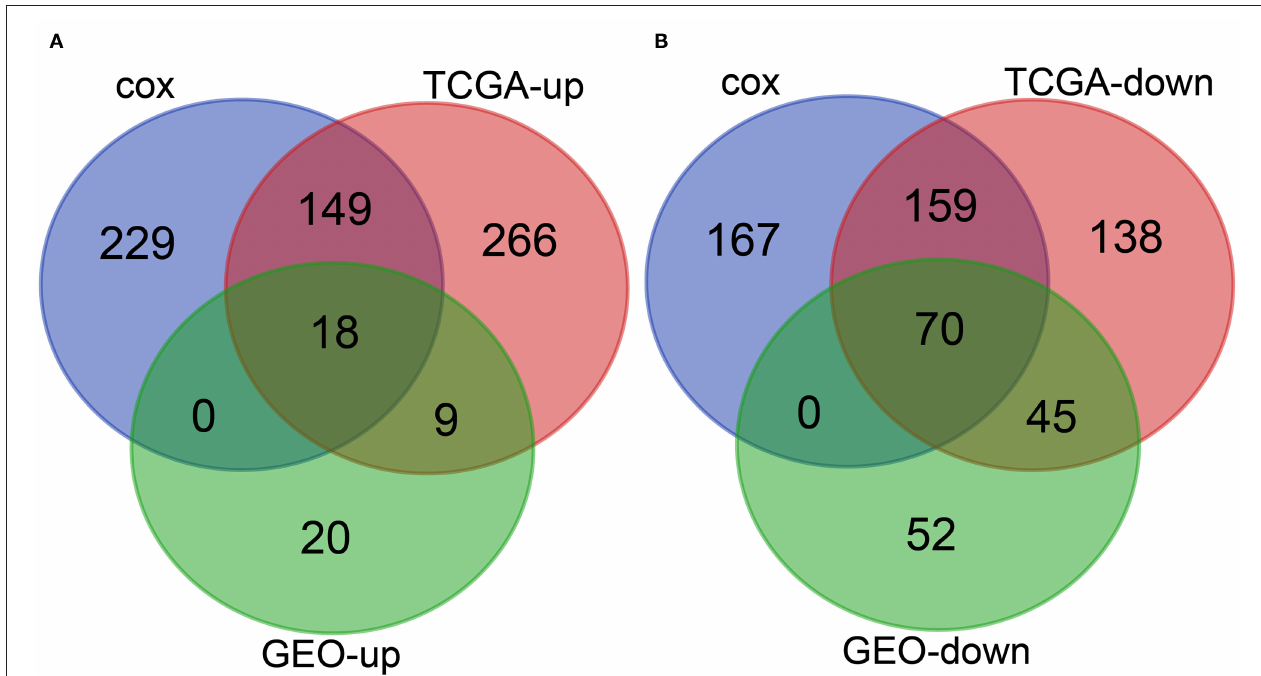
FIGURE 4 | Joint screening of prognosis-related differential genes in the TCGA and GEO databases. (A) , Venn diagram of the upregulated genes in HCC samples and the prognosis-related genes. The three circles in the figure respectively represent the upregulated genes in TCGA-LIHC samples, the upregulated genes obtained from the joint differential analysis of the three HCC-related gene expression datasets in the GEO database, and the genes with p value less than 0.05 in Cox univariate analysis. The middle part represents the intersection of three groups of data. (B) , Venn diagram of the downregulated genes in HCC and prognosis-related genes. The three circles in the figure respectively represent the downregulated genes in TCGA-LIHC samples, the downregulated genes obtained from the joint differential analysis of the three HCC-related gene expression datasets in the GEO database, and the prognosis-related genes obtained from univariate Cox analysis. The middle part represents the intersection of three groups of data.